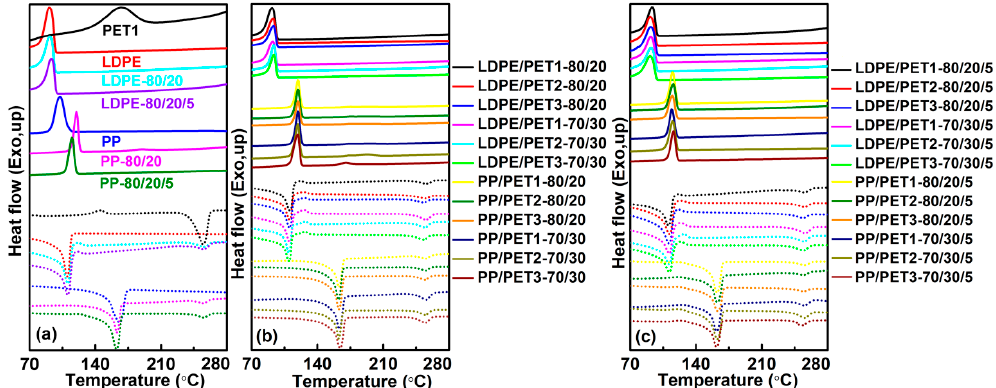
Figure 1. Cooling (solid line) and heating (short dot line) DSC scans of polymers and polymer blends, ( a ) polymers and blends; ( b ) incompatible polyolefin/PET blends; ( c ) compatibilized polyolefin/PET blends. Table 3. The crystallization temperature and melting point of polymer blends.